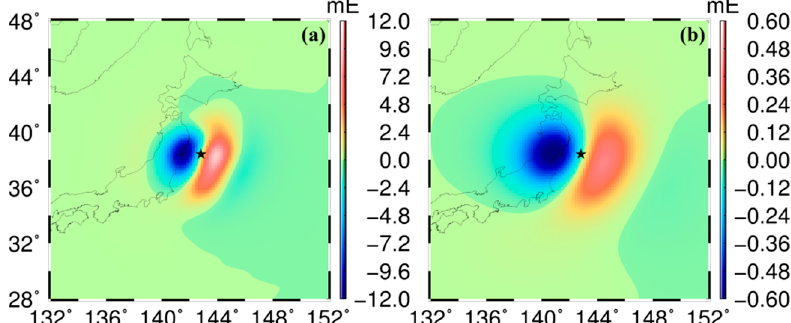
Figure 4. Coseismic radial gravity gradient change ( a ) on the Earth’s surface and ( b ) on a sphere with a height of 260 km when using spherical harmonic coefficients up to d/o 250 with a Gaussian filter applied (radius of 110 km). The units are mE.